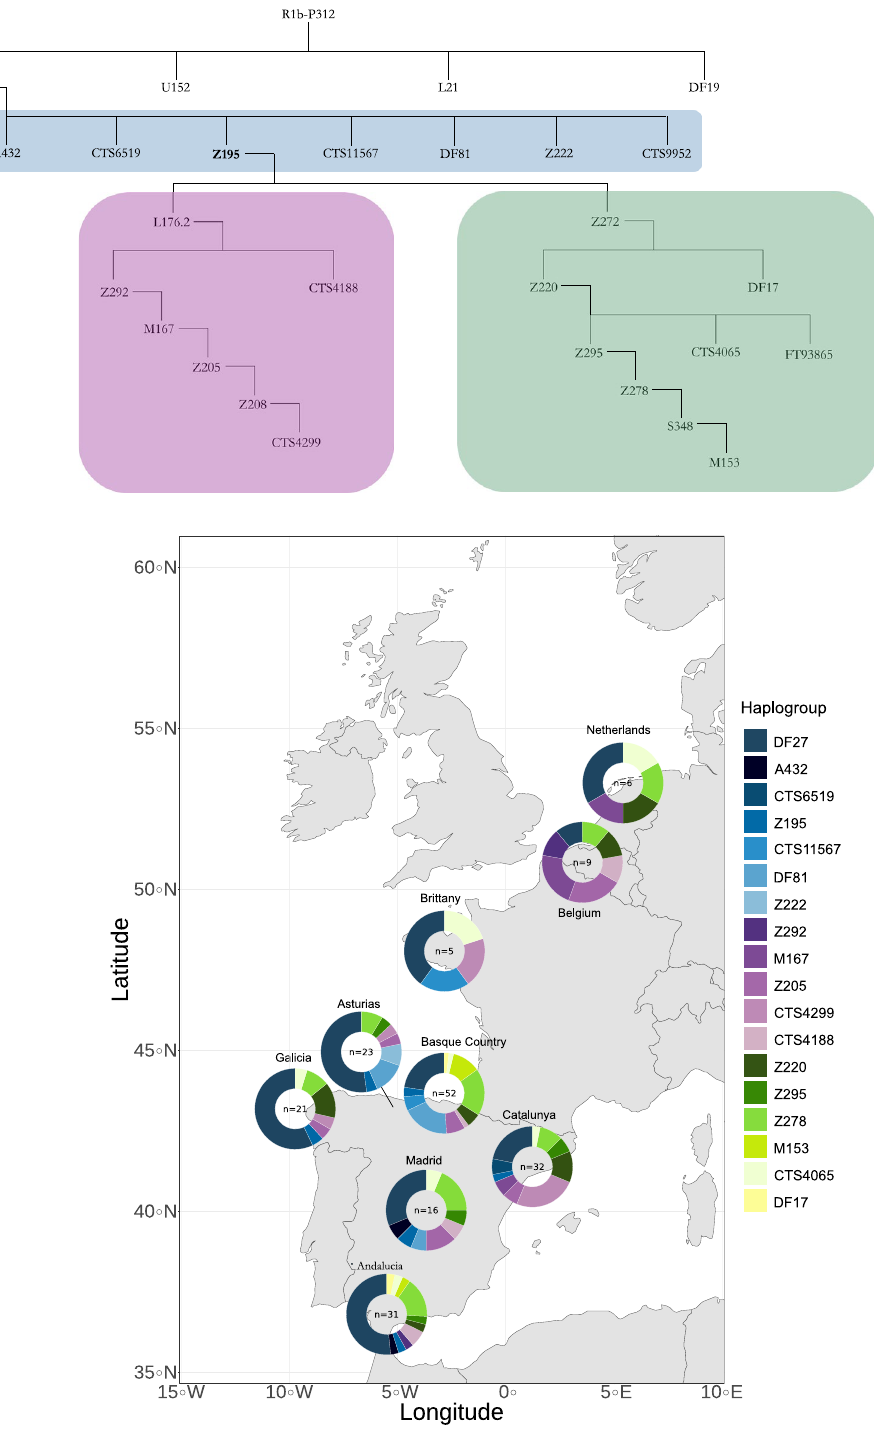
Figure 2. On top, schematic phylogeny of the SNPs in the ISOGG 2019–2020 tree found in our samples. Note that, as discussed in the text, our results can be used to refine the ISOGG 2019–2020 phylogeny. Bottom, haplogroup frequencies in our samples, as defined by the terminal SNP (i.e., all other branch-defining SNPs below that SNP and mapping to the TR were found to be ancestral). Map source: mapplots 1.5.1 R